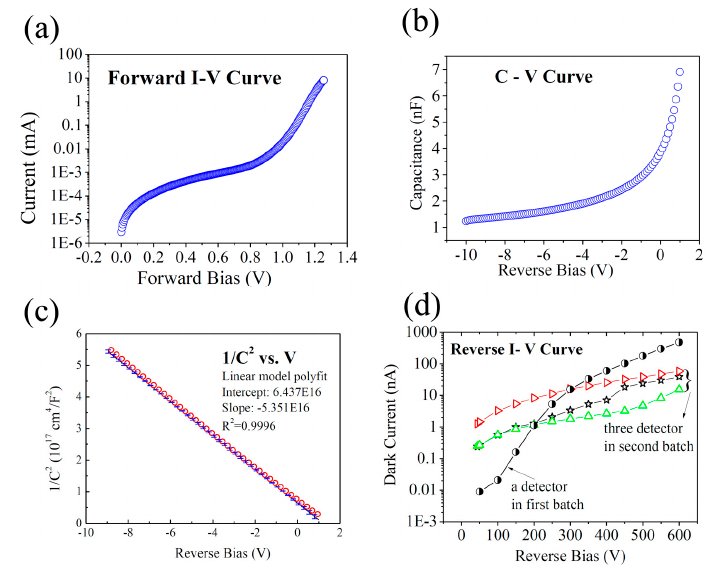
Figure 3. Electric parameters of the 4H-SiC diode: ( a ) Forward I-V of one chip; ( b ) C-V curve of one chip ; ( c ) 1/C 2 -V plot of one chip; ( d ) Reverse I-V (Dark current) of an SiC detector from the PCB group (half block circle in black) and three detectors from the ceramic shell group (open right-triangle in red, open star in black, and open up-triangle in green) from the four pixel structure at a reverse bias of 600 V.